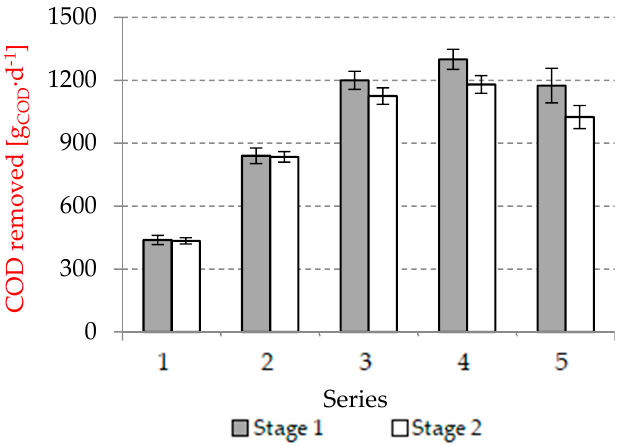
Figure 5. Daily COD removed.